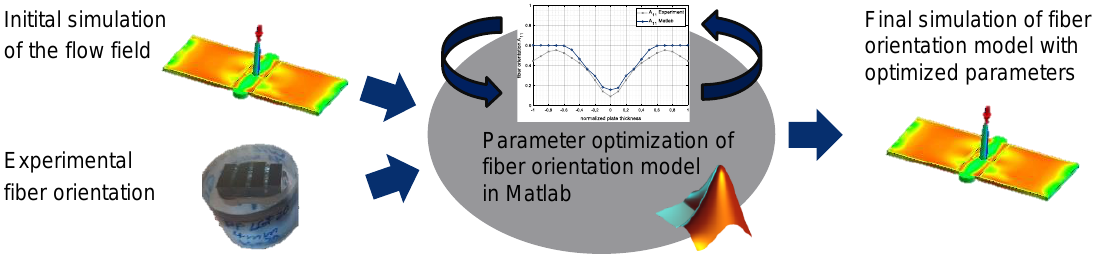
Figure 16. Process scheme of the fiber orientation optimization tool.